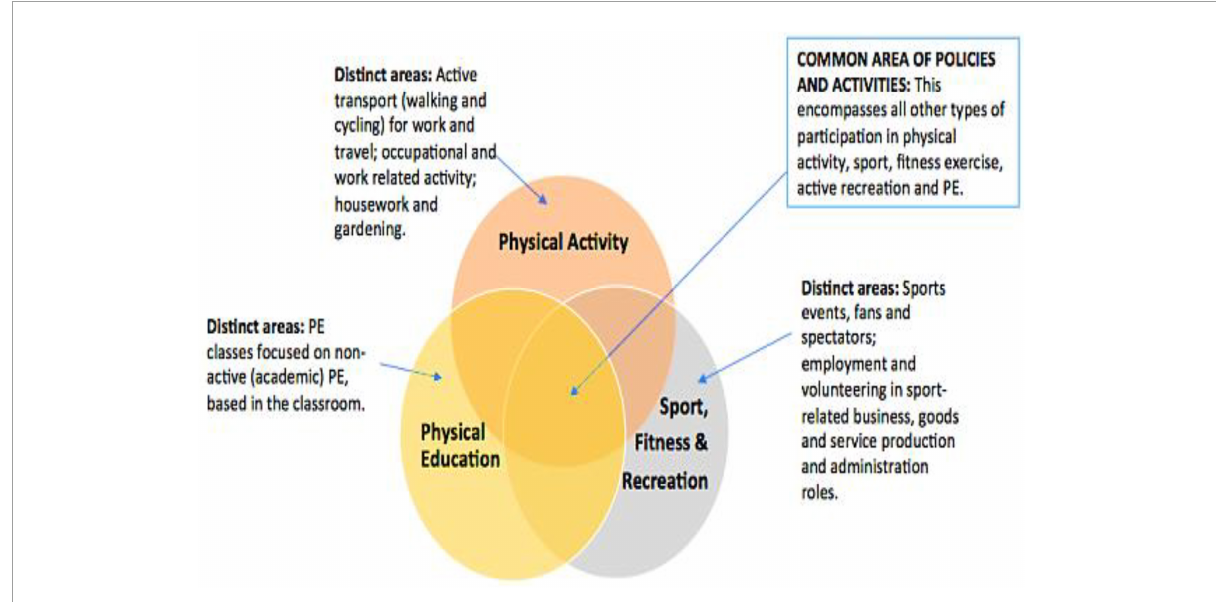
FIGURE3 Physical education development model (author’s